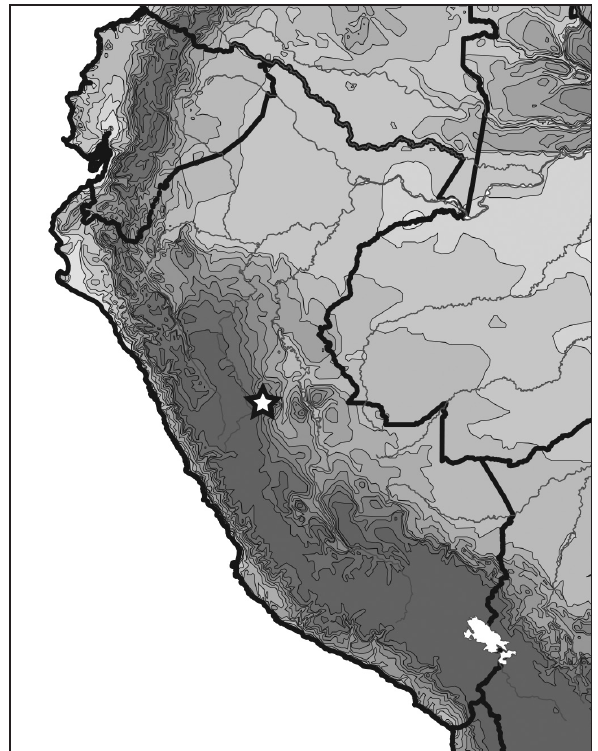
Figure 5. Novadessus viracocha sp. n.